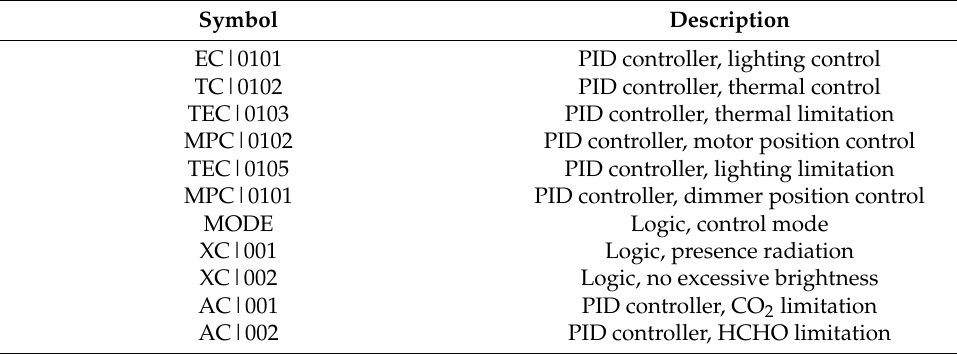
Figure 11. Architecture of the modified control system (IAQ control).